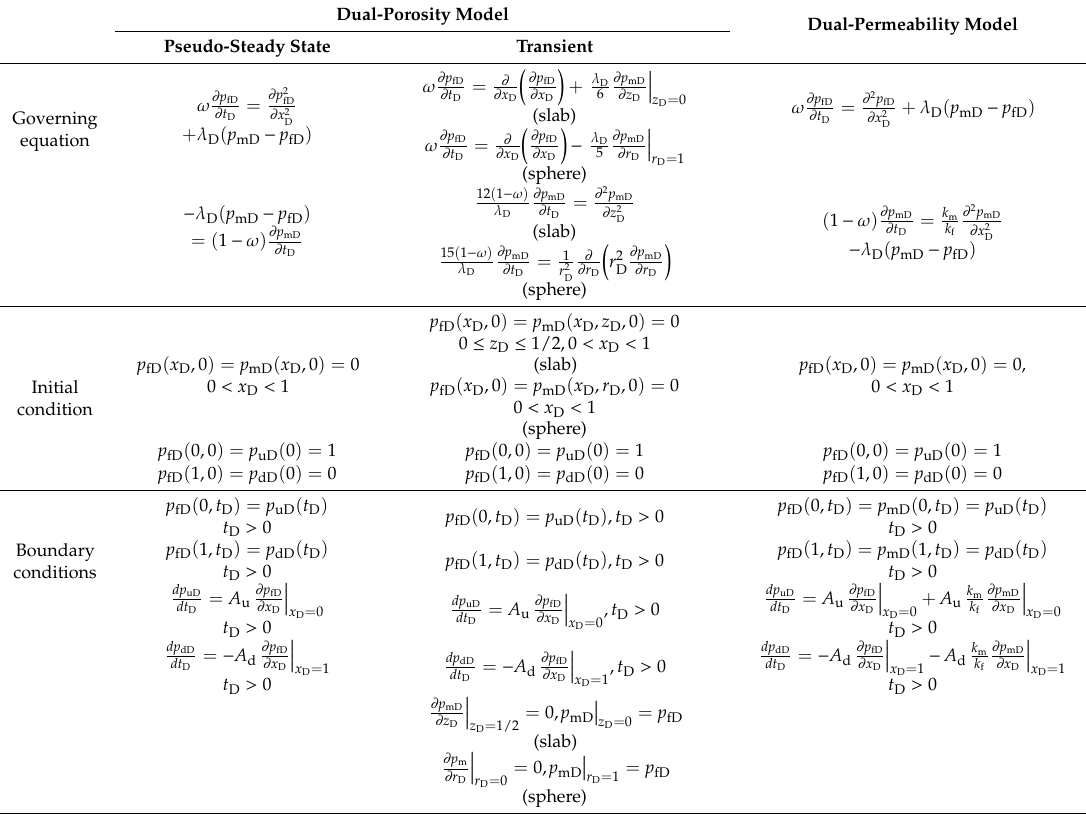
Table 1. Comparison of dimensionless dual-continuum medium